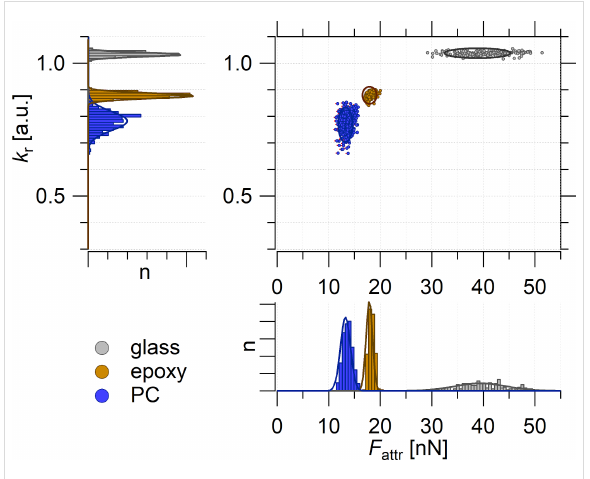
Figure 3: The property domain of FDCs (average of ≈ 100 single curves) of bulk materials: PC (blue), epoxy (brown), and glass (grey). Top-left and bottom-right panels are histograms of k r and F attr , respec- tively. The top-right panel is the k eff / F attr diagram for the structure–property correlation. The measurements were performed with the tip